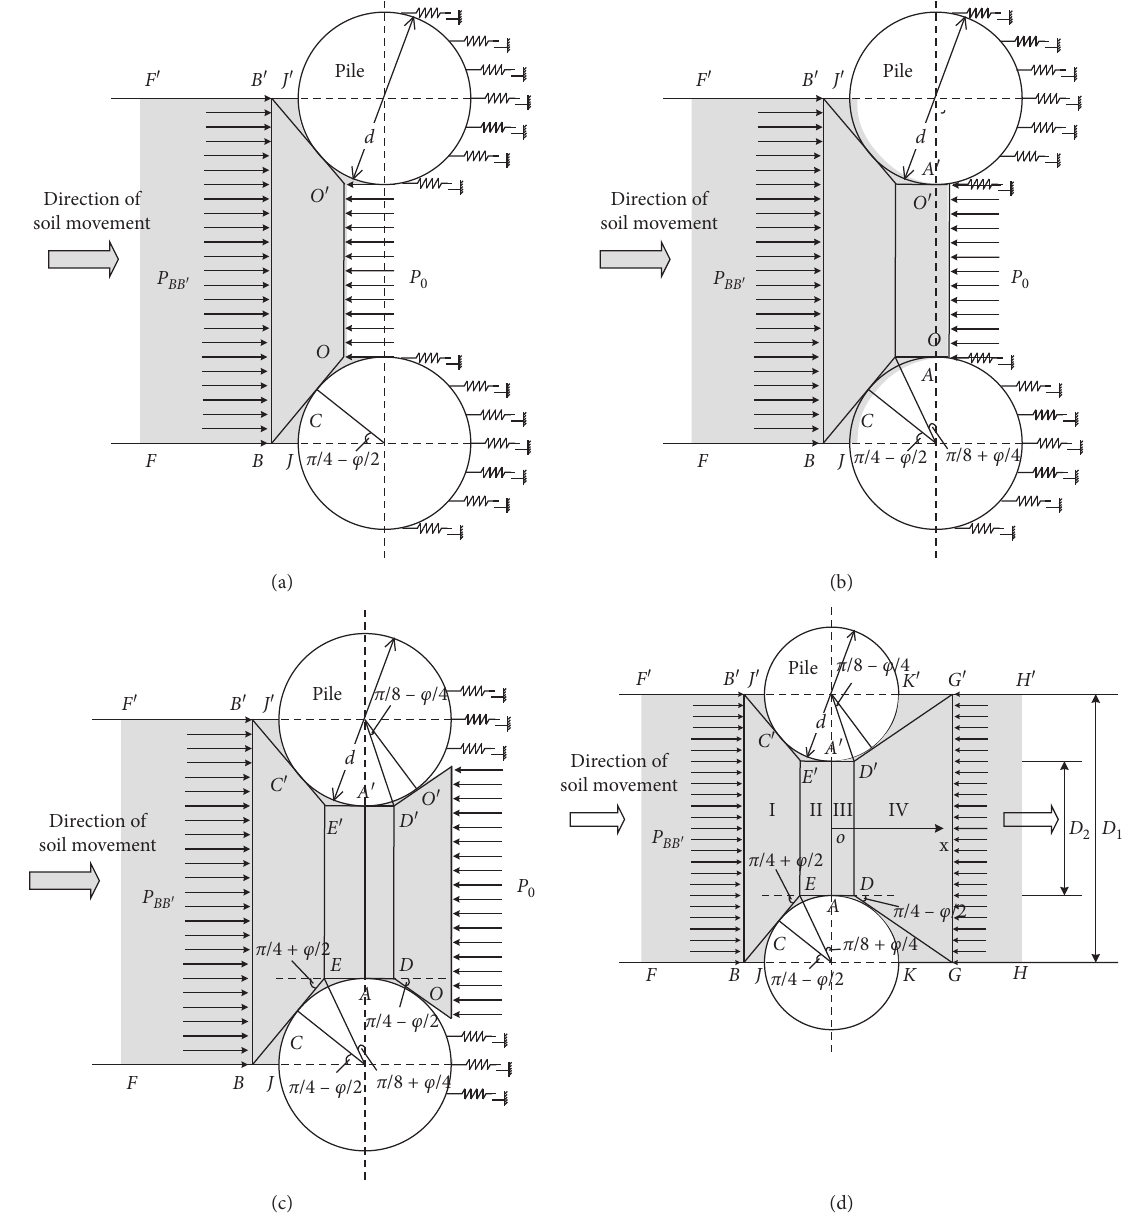
Figure 2: Soil-pile load transfer model. Plastic deformation zone (a) just before the piles, (b) developing to the middle of the piles (c) developing to the rear of the piles, and (d) all through the